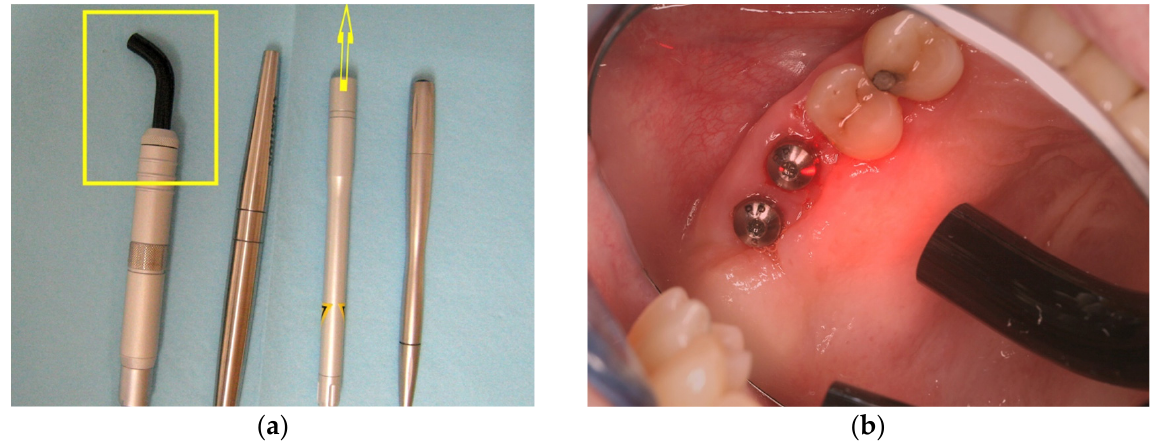
Figure 1. ( a ) Specific laser handpiece for photobiomodulation (in yellow, other ones are for biostimulation and decontamination settings); ( b ) PBM with laser in implantology. Photobiomodulation (PBM) is simple to use, painless, has no side effects and has